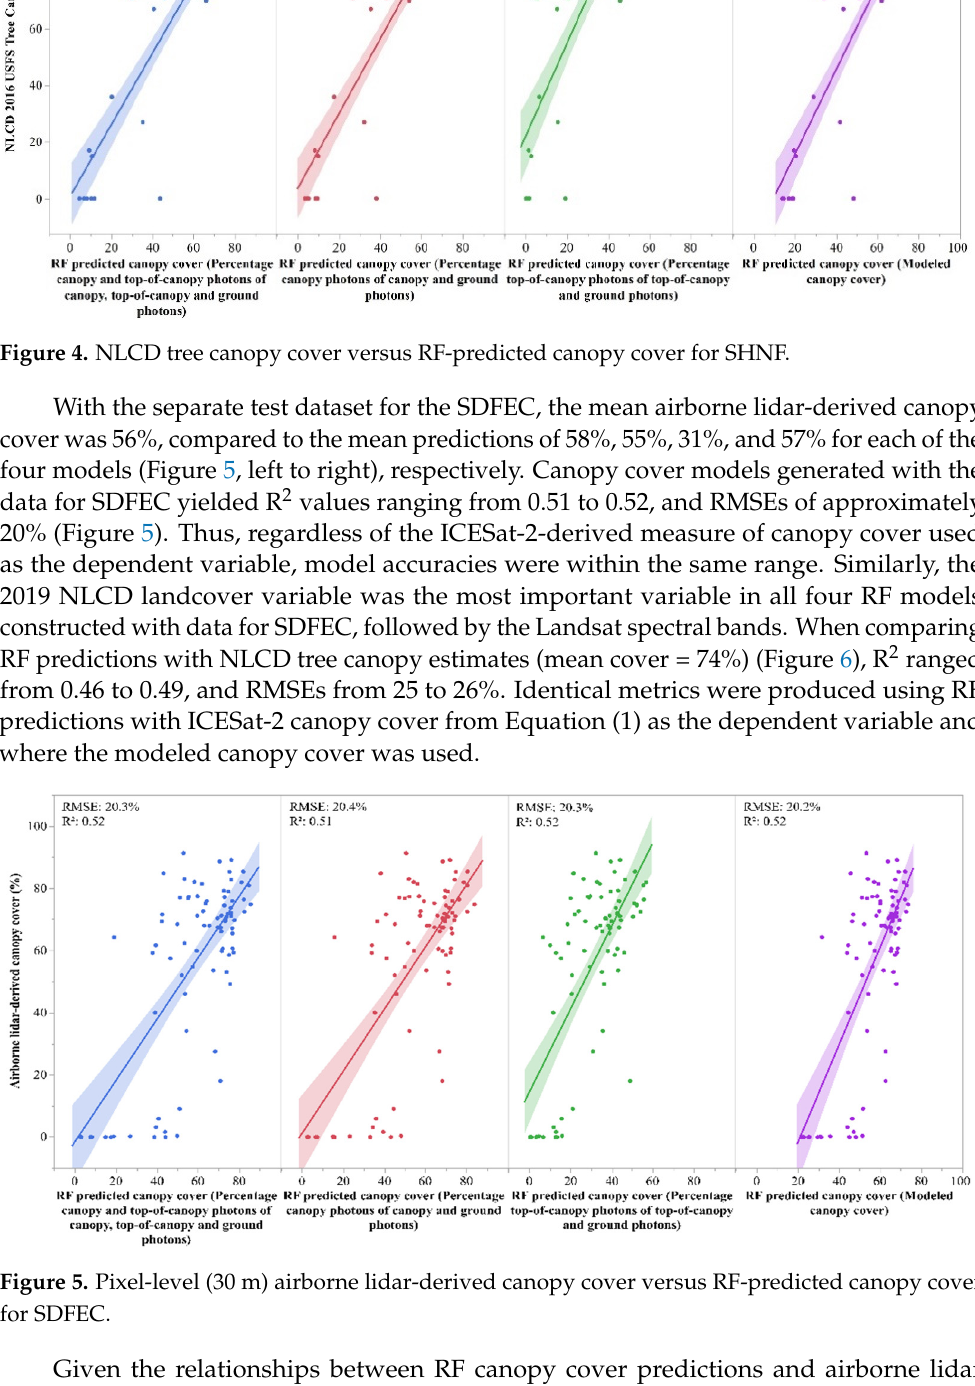
Figure 3. Pixel-level (30 m) airborne lidar-derived canopy cover versus RF-predicted canopy cover for SHNF.